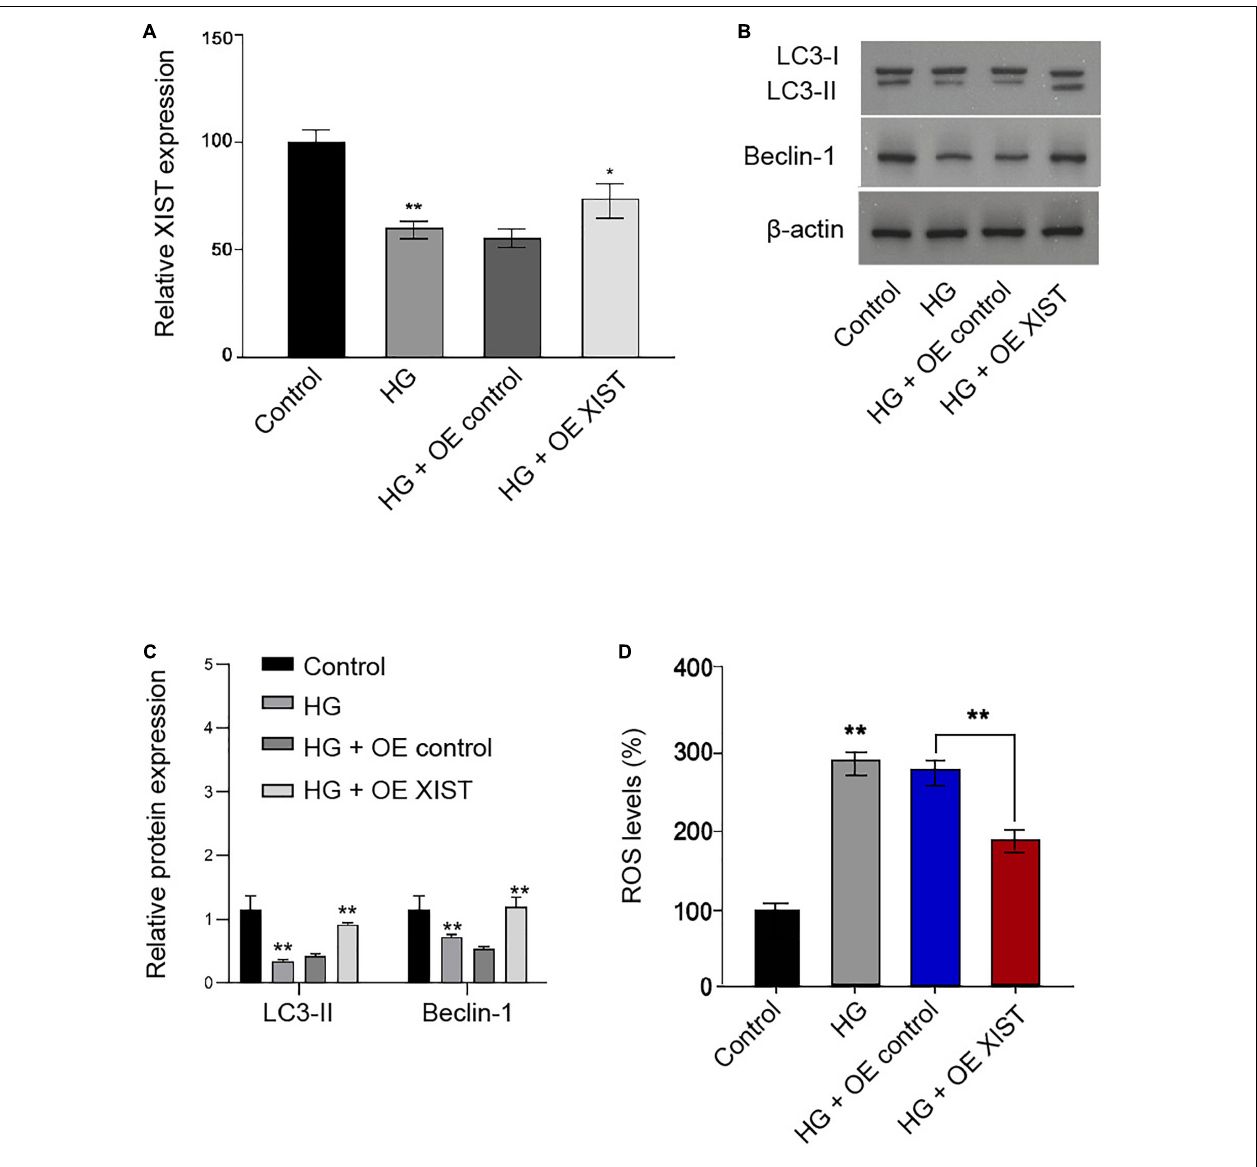
FIGURE 3 | XIST induces autophagy and inhibits oxidative stress in the HG-treated Schwann cells. (A–D) The RSC96 cells are treated with HG, or co-treated with HG and pcDNA-3.1-XIST overexpression vectors. (A) The expression of XIST is measured by qPCR assays. (B,C) The expression of LC3I, LC3II, and Beclin-1 is assessed by Western blot analysis. (D) DCFH–DA staining shows the ROS production. N = 3, mean ± SD, * P < 0.05, ** P <